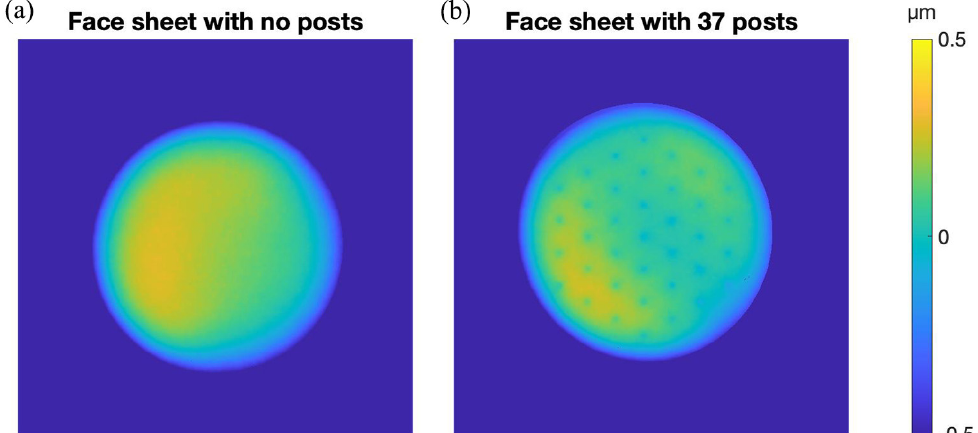
Figure 8. Surface topography maps of two 12 mm diameter edge-supported face sheets fabricated from the 10 µ m thick device layer of a silicon-on-insulator wafer. ( a ) Face sheet with no posts. Deviation from flatness over the entire surface was 250 nm-rms. Local deviation from flatness in a 1.5 mm square region was 5 nm-rms. ( b ) Face sheet with 37 posts etched into the handle layer. Deviation from flatness over the entire surface was 180 nm-rms. Local deviation from flatness in a 1.5 mm square region was 29 nm-rms.